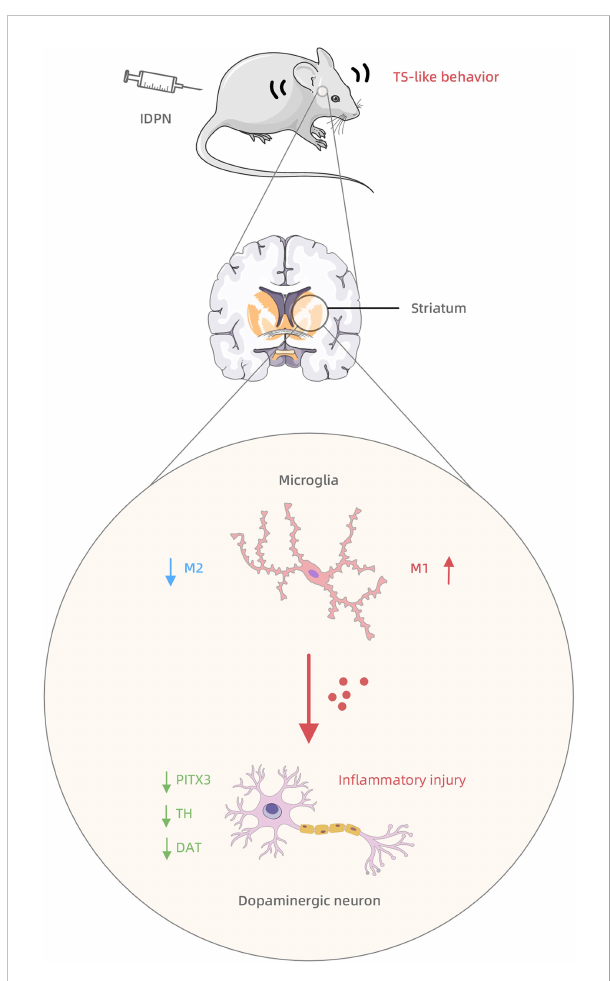
FIGURE 5 The mechanism summary diagram of IDPN-induced TS development involving the striatal microglia-dopaminergic-neuron